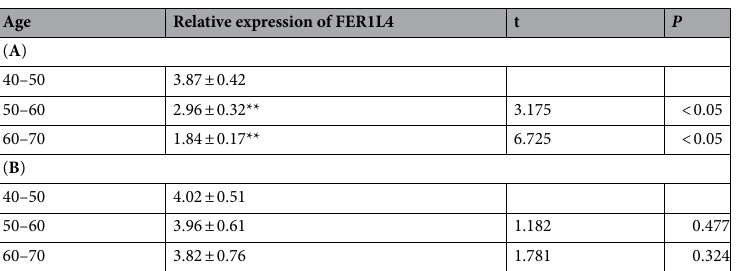
Table 2. FER1L4 was decreased with age in synovial fluid of OA patients not in healthy control. (A) Relative expression of FER1L4 in different age groups of OA patients. (B) Relative expression of FER1L4 in different age groups of healthy controls. ** P <